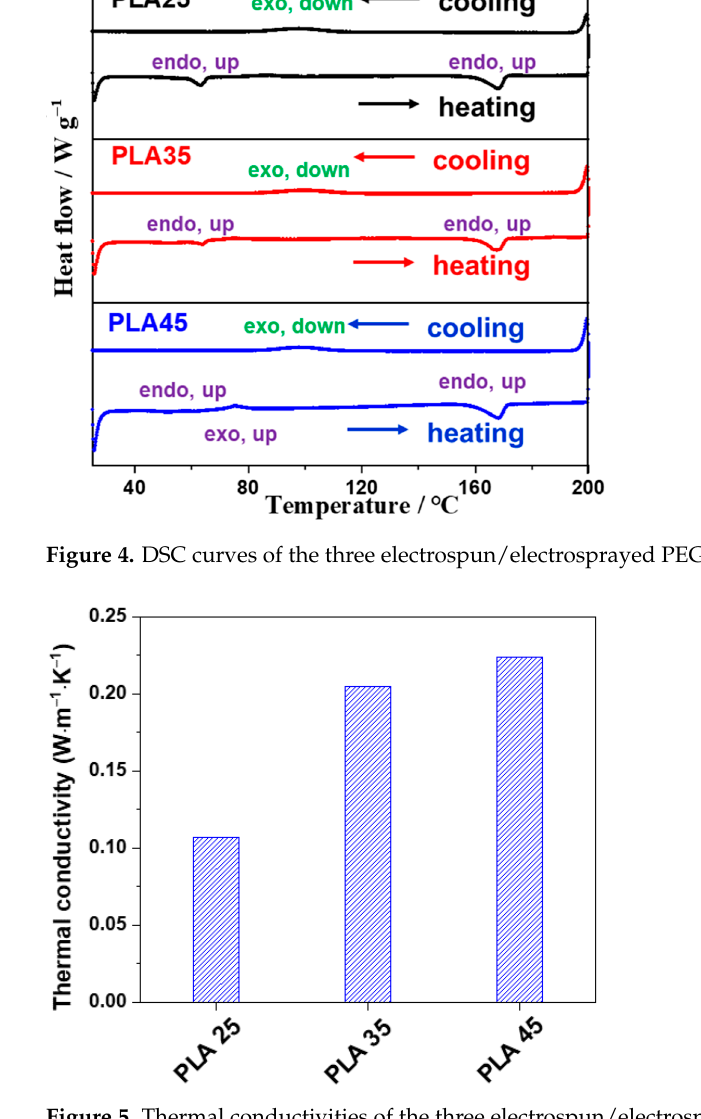
Figure 6. Contact angles for the three electrospun/electrosprayed PEG/PLA films.